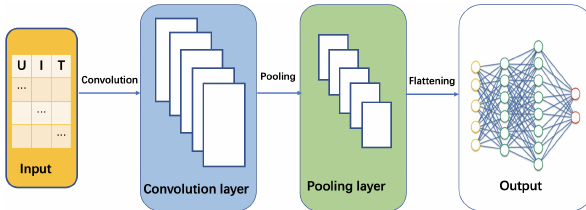
Figure 9. The structure diagram of